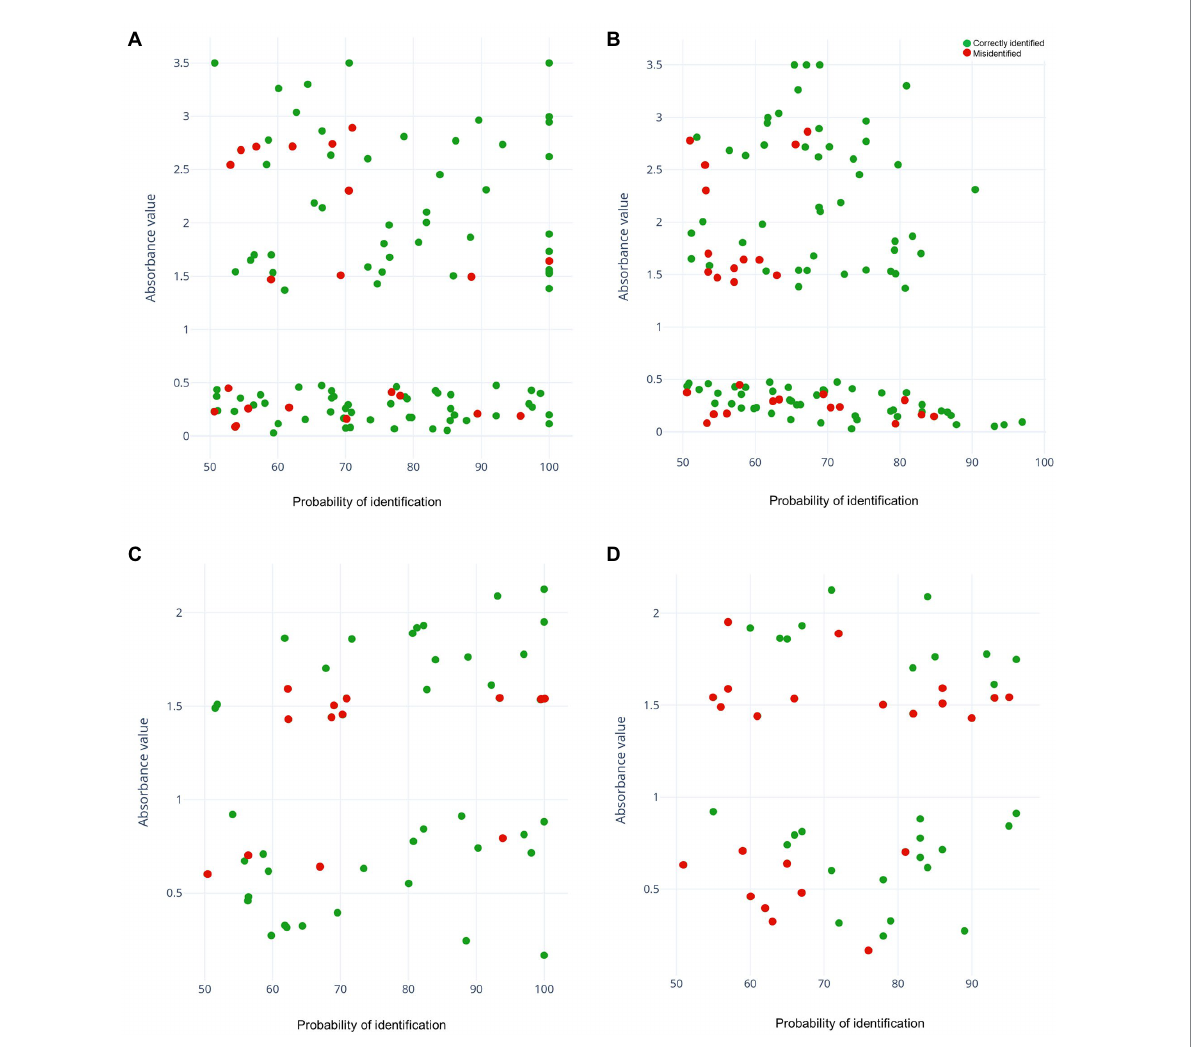
FIGURE 2 Representation of all strains analyzed according to their absorbance values and the probability of identification obtained using the predictive models. Green dots represent the correctly identified strains and red dots represent misidentified strains. (A) Partial least squares-discriminant analysis (PLS-DA) model for Staphylococcus aureus . (B) Random forest (RF) model for S . aureus . (C) PLS-DA model for Candida albicans . (D) RF model for C . albicans .